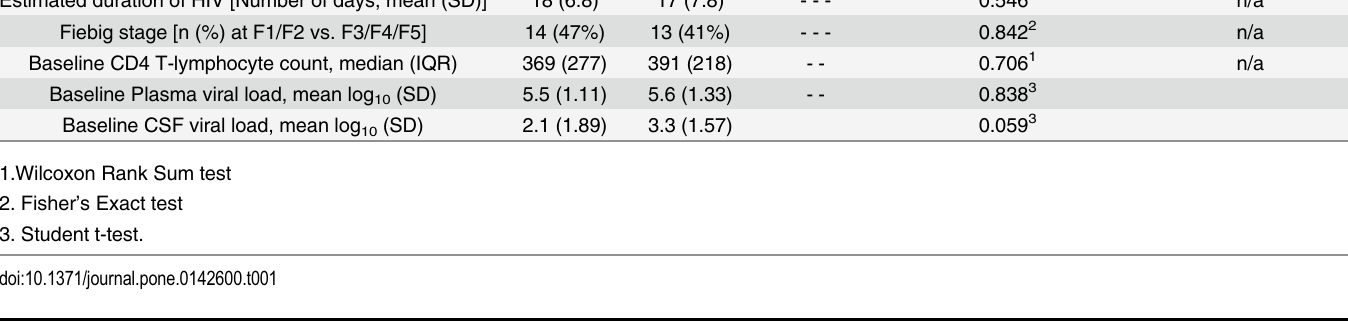
Fiebig stage [n (%) at F1/F2 vs. F3/F4/F5] 14 (47%) 13 (41%) Baseline CD4 T-lymphocyte count, median (IQR) Baseline Plasma viral load, mean log 10